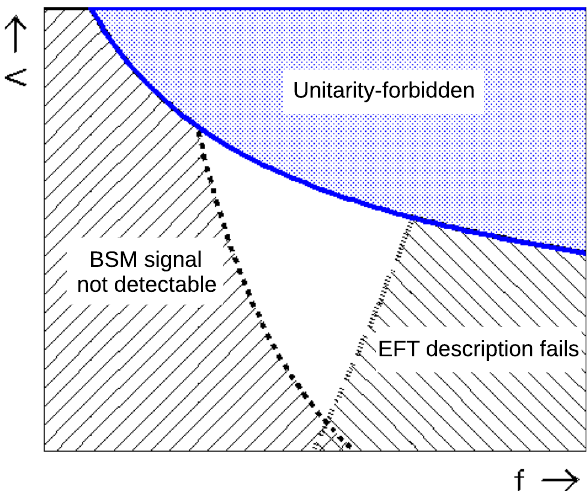
Fig. 1 Cartoon plot which shows the regions in f i and (cid:3) (for an arbi- trary higher-dimension operator O i ) in terms of BSM signal observ- ability and applicability of EFT “models” based on the choice of a higher-dimension operator in an analysis of the same-sign VBS pro- cess with purely leptonic decays. The central white triangle is the most interesting region where the underlying BSM physics can be studied within the EFT